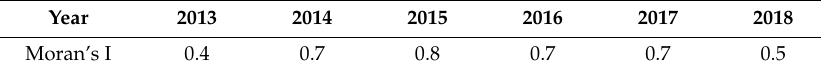
Table 2. Global Moran’s index of PM 2.5 in BTH from 2013–2018.